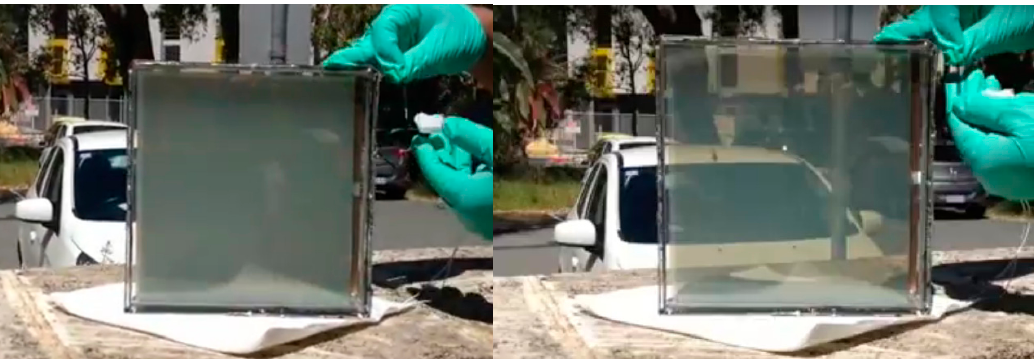
Figure 5. Transparency-controlled, self-powering PDLC-integrated “smart” solar window demonstration at Edith Cowan University (ECU) in October, 2014. A 200 mm × 200 mm hybrid concentrator-type solar window used four parallel-connected edge-mounted CuInSe 2 modules of size 198 mm × 25 mm, the electric output of which was sufficient to control the embedded PDLC layer transparency within a broad transparency range [108].